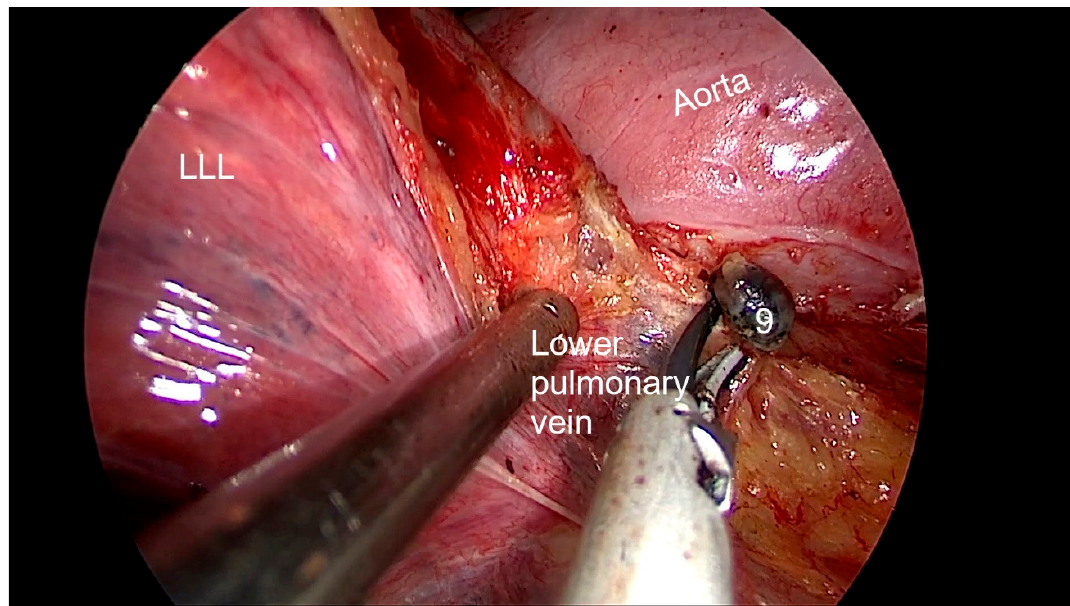
Figure 12. Anatomic landmarks during left pulmonary ligament lymph node dissection (9).